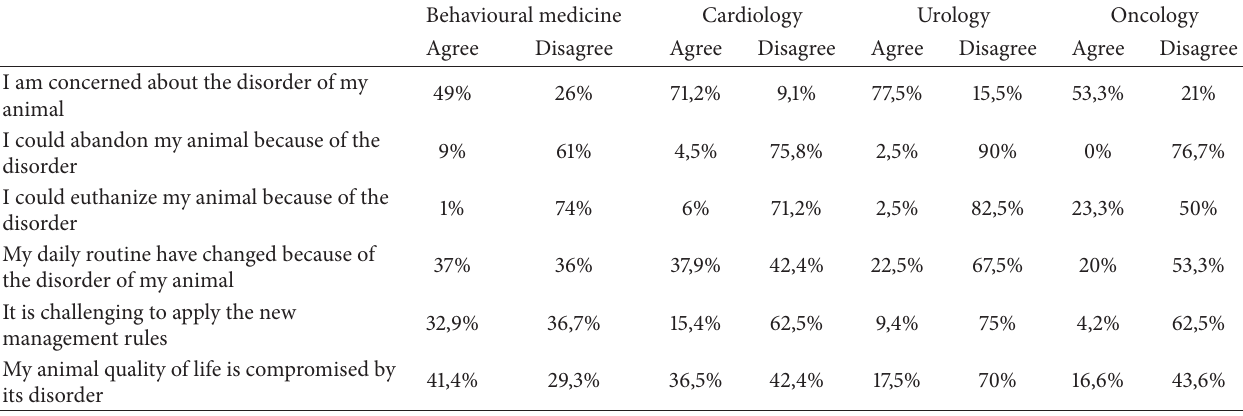
Table 3: Results obtained by the four fields during the first